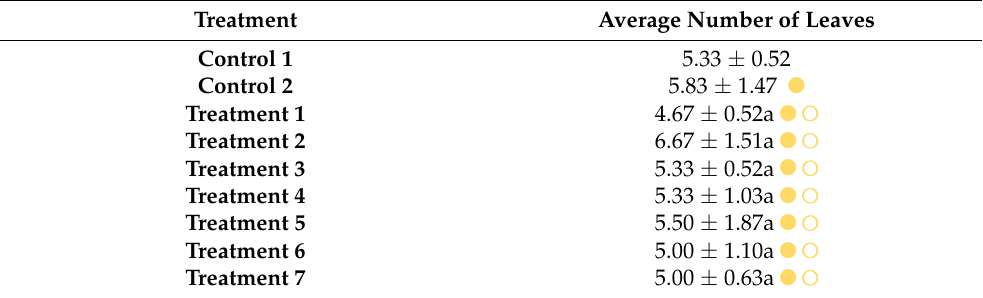
Closed ( ⬤ ) and open ( 〇 ) circles indicate comparisons withs Controls 1 and 2, respectively. Green, yellow, and red circles indicate that the values are higher than, equivalent to, or lower than those observed in the controls, according to the Kruskal–Wallis test ( p ≤ 0.05) and pairwise comparison with the Dunn test ( p ≤ 0.05). Means followed by the same letter do not differ statistically. Control 1: control without inoculation + fertilization 100% of N and P; Control 2: control without inoculation + fertilization 30% of N and P; Treatment 1: Azospirillum brasilense (Ab-v5), Treatment 2: Bacillus megaterium (0004); Treatment 3: Brevibacillus fluminis (MET12M2); Treatment 4: Ab-v5 + 0004; Treatment 5: Ab-v5 + MET12M2; Treatment 6: 0004 + MET12M2; Treatment 7: Ab-v5 + 0004 + MET12M2.